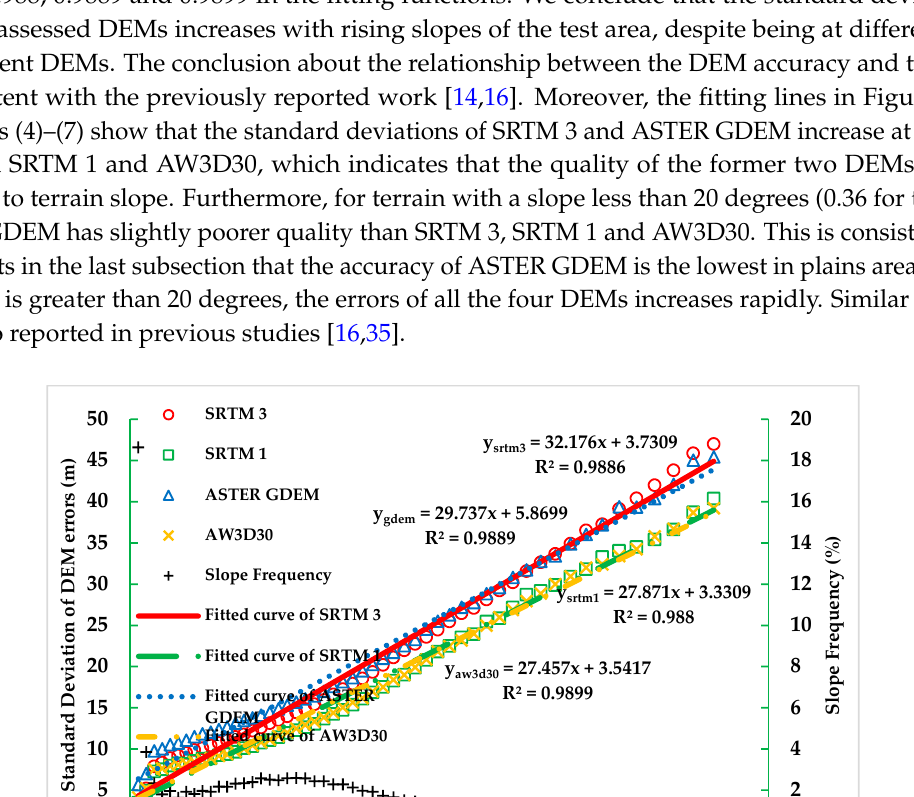
Figure 3. The relationship between DEM standard deviation and tangent of slope angle.